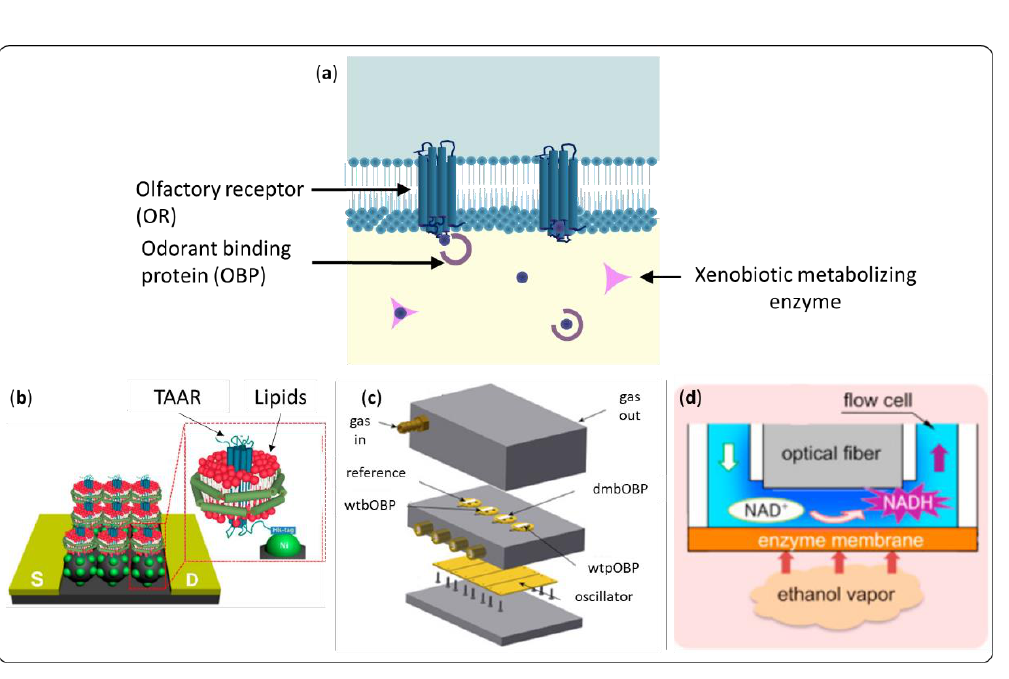
Figure 2. Proteins interacting with volatile organic compounds (VOCs) in the human nose ( a ) and examples of olfactory sensors designed from biosourced materials ( b ). Trace amine associated receptors (TAAR) in lipidic nanodiscs grafted on a field-e ff ect transistor for the detection of cadaverine (adapted from [15]). ( c ) Three di ff erent kind of odorant binding proteins (OBPs) deposited on surface acoustic wave sensors for carvone sensing (adapted from [16]). ( d ) Optical sensor for ethanol based on an alcohol dehydrogenase membrane